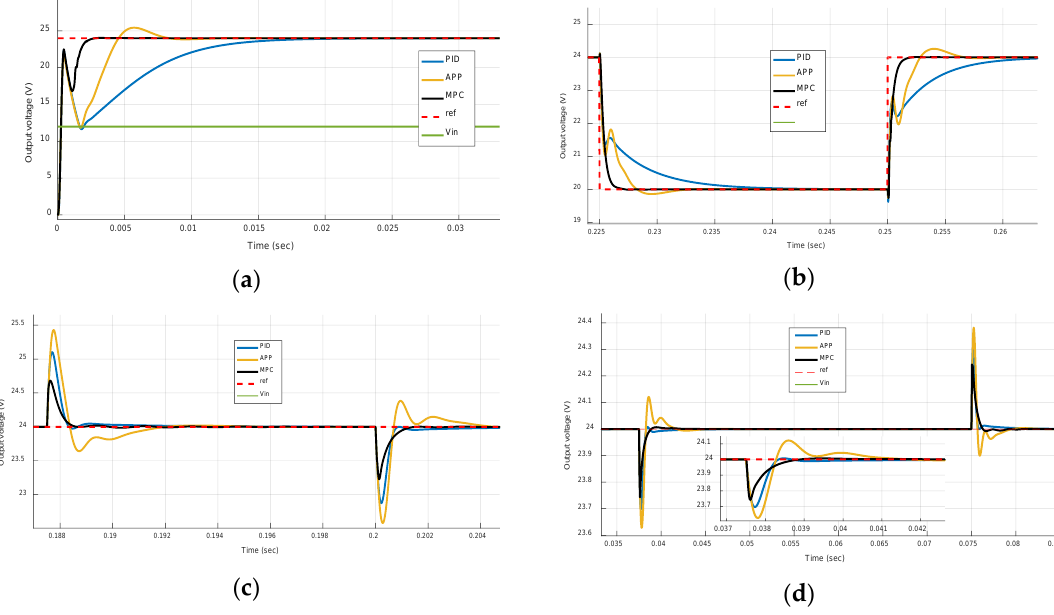
Figure 4. Comparative transient responses of the three controllers PID, APP (PID + ROAPC), and MPC. ( a ) Startup transient response for tracking a reference input of 24 V with an input voltage Vin = 12 V; ( b ) reference input changes from 24 V to 20 V and back; ( c ) rejection of load step changes (from 10 to 50 Ω and back); ( d ) dealing with step changes in the input voltage (from 12 to 10 V and back). It is noted that a lower sampling frequency is enough for a successful reference governor